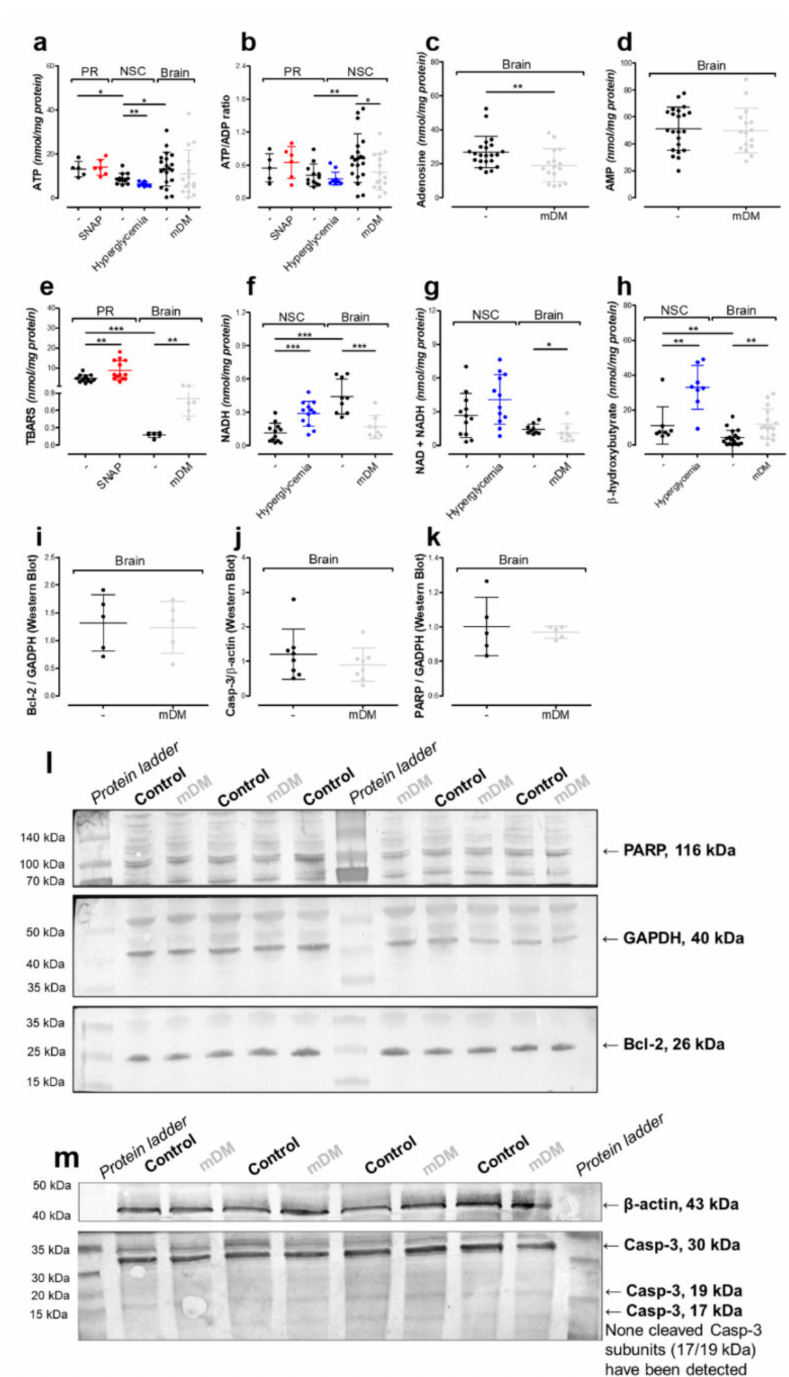
Figure 6. The impact of the toxic factors on intracellular homeostasis measured in primary neurons (PR), neural stem cells (NSC) and brain tissues (Brain). Nucleotides: ( a ) ATP level; ( b ) ATP / ADP ratio; ( c ) adenosine level; ( d ) AMP level; ( f ) NADH (reduced nicotinamide adenine dinucleotide) level; ( g ) total NAD (nicotinamide adenine dinucleotide) level. ( e ) TBARS level, cytosolic oxidative stress markers. ( h ) β -hydroxybutyrate level, ketoacidosis markers. Apoptosis markers (protein level measured by Western blot): ( i ) B cell lymphoma 2 (Bcl-2); ( j ) caspase-3 and cleaved caspase-3 (Casp-3); ( k ) poly-(ADP-ribose)-polymerase (PARP). Representative WB membrane images for: ( l ) PARP, Bcl-2, and GAPDH (glyceraldehyde 3-phosphate dehydrogenase) proteins; ( m ) Casp-3, cleaved Casp-3, and β -actin proteins. Data are means ± SD from 3 to 22 observations per group. Significantly di ff erent from the control: * ( p –value < 0.05), ** ( p –value < 0.01), *** ( p –value <